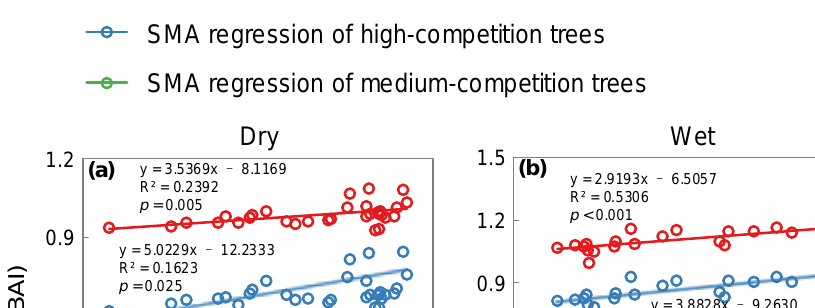
Figure A1. Negative exponential regression ( n = 82) between ( a ) individual tree competition index ( CI ) and diameter at breast height (DBH), ( c ) individual tree CI and tree height. Linear regression ( n = 82) between ( b ) individual tree CI and tree age.